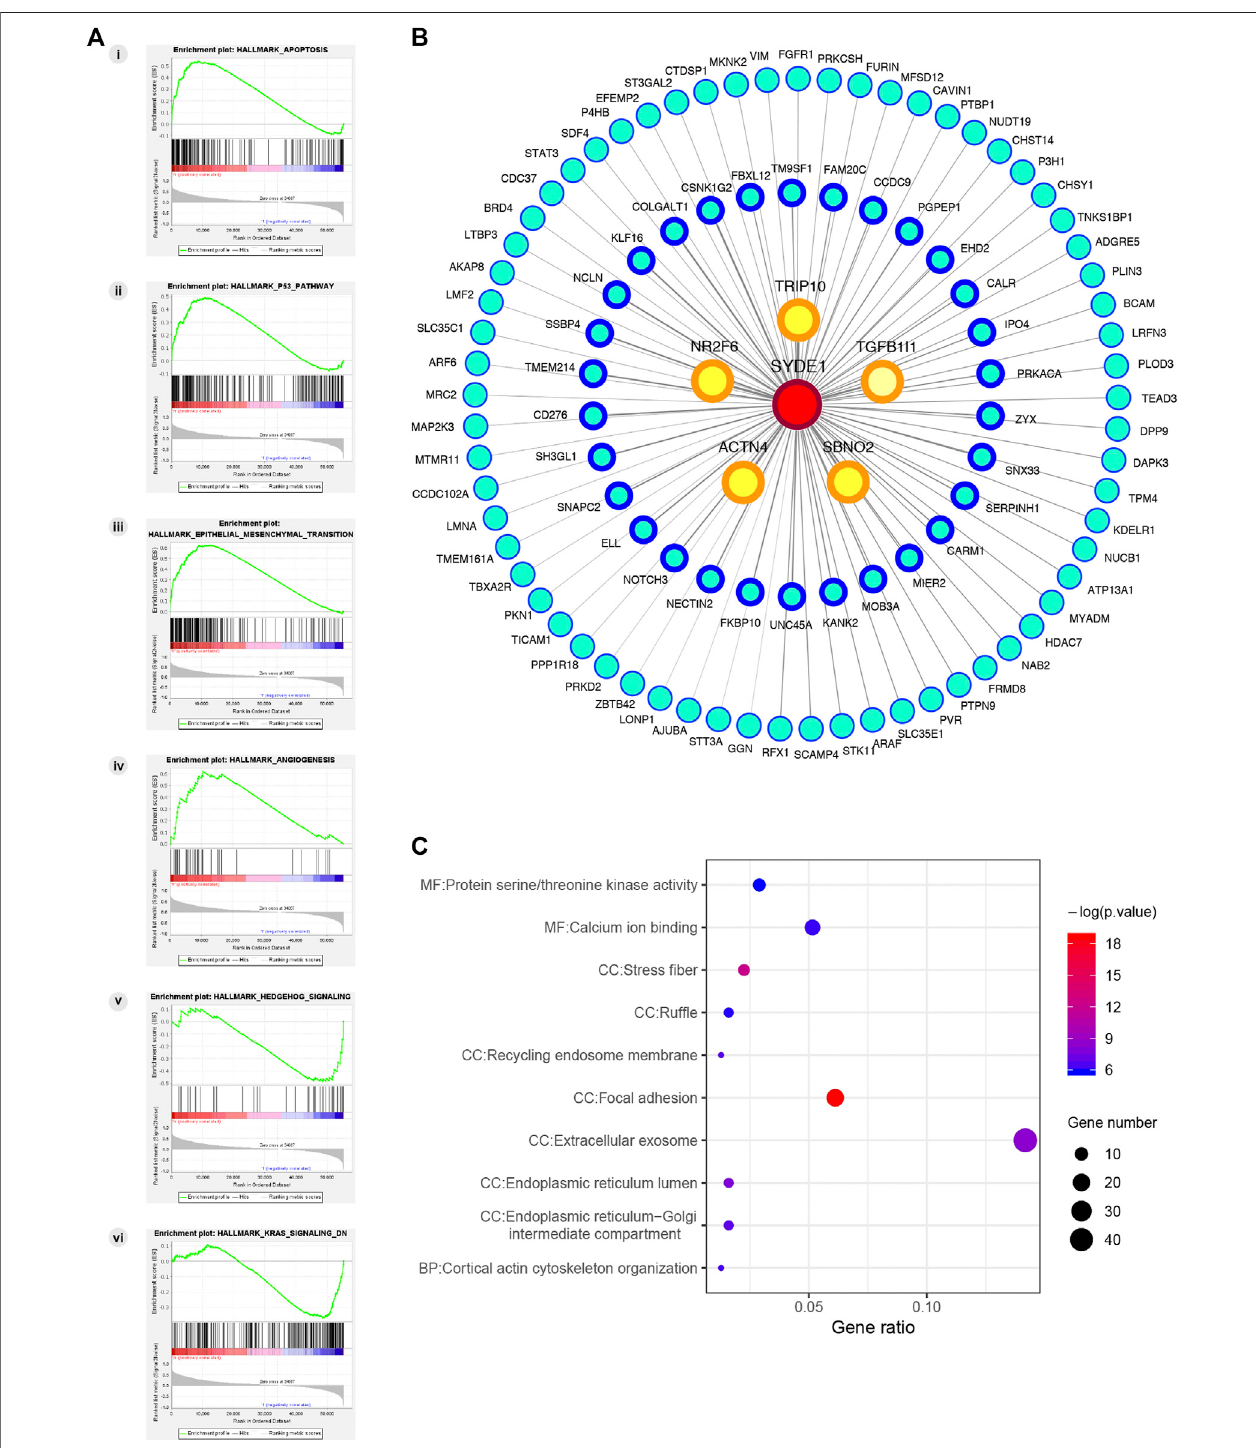
FIGURE 9 | Potential molecular mechanism of SYDE1 in glioma. (A) GSEA pathway using single-gene method of SYDE1 . (i-iv) Enriched gene sets in the group of high SYDE1 expression. (v-vi) Enriched gene sets in the group of low SYDE1 expression. (B) The PPI network of the top 100 genes co-expressed with SYDE1 in glioma tissues. (C) GO enrichment results of 100 genes involved in PPI network.